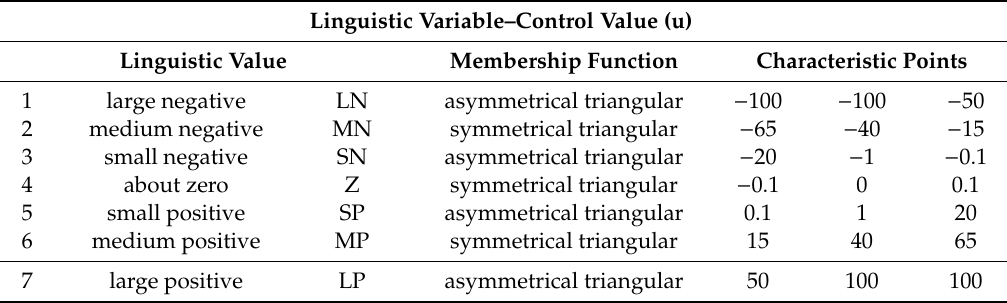
Table 3. The first version of the controller–control